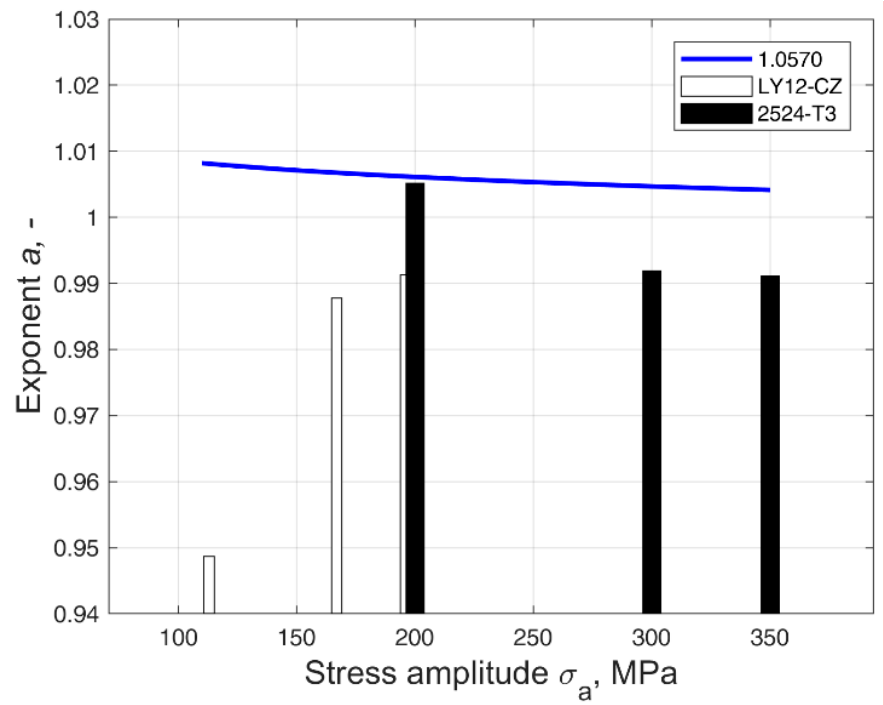
Figure 4. Value of the exponent a in the cases of the 1.0570 steel and the LY12-CZ and 2524-T3 aluminium alloys in relation to the stress amplitude.